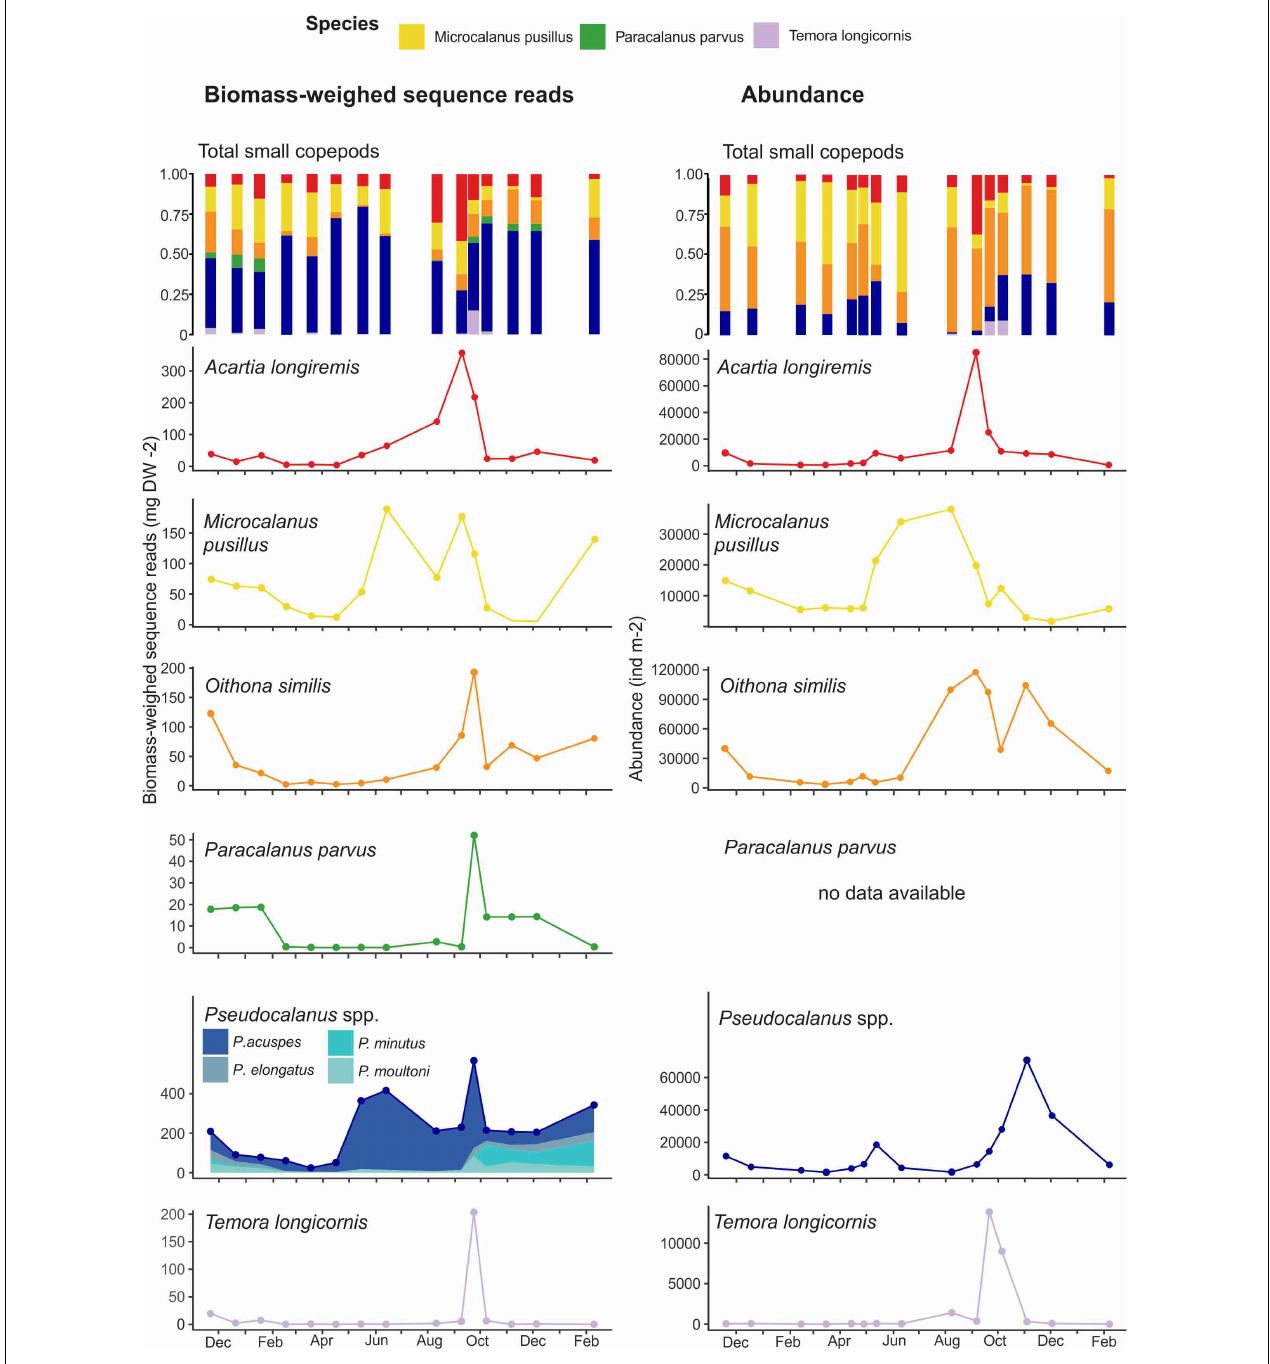
FIGURE 4 | Seasonal changes in small copepod BWSR (mg DW m − 2 , left column ) and abundance (individuals m − 2 , right column ) in Ramfjord between November 2018 and February 2020. The first row represents the relative proportion of the main small copepod species to the small copepod community remaining rows represent the seasonal variation of the main small copepod